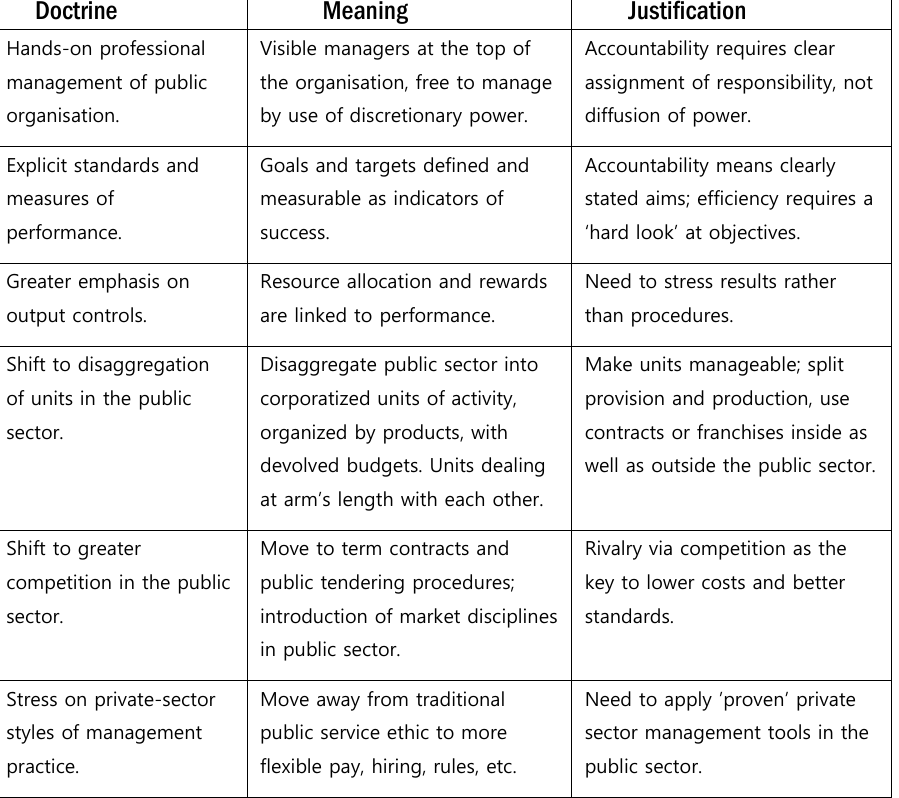
TABLE 1: Central Doctrine of New Public